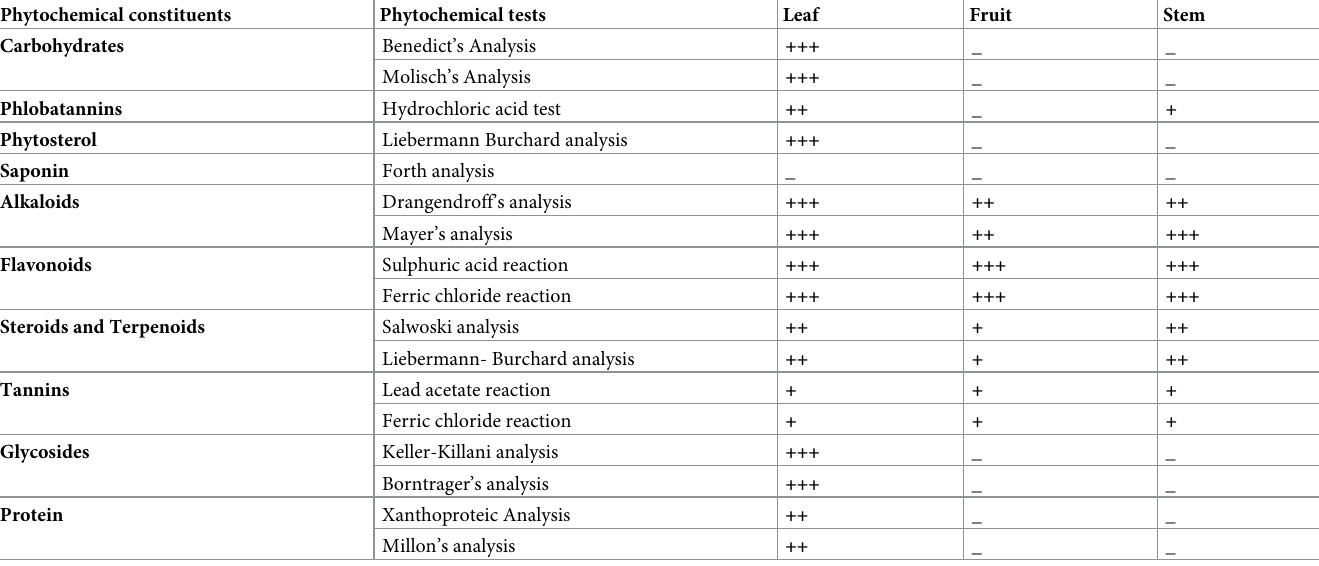
Table 1. Phytochemical qualitative analysis of E . spinosa MeOH extract from Mirpur AJK, Pakistan. Phytochemical constituents